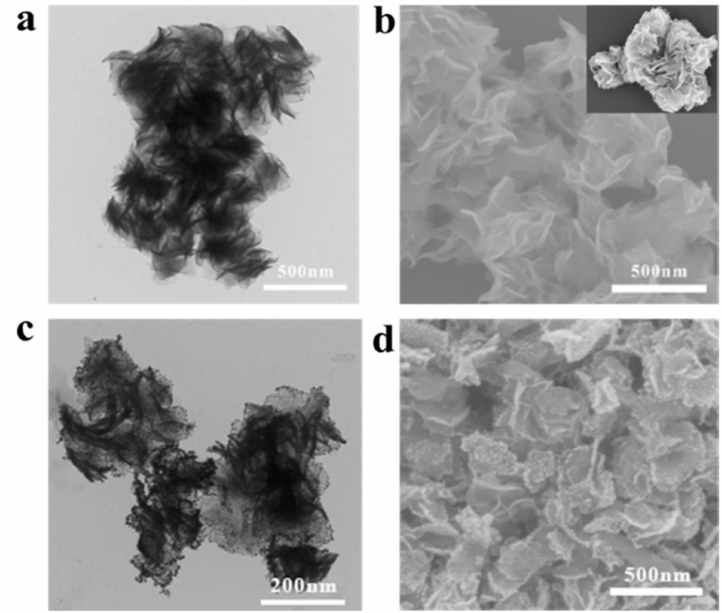
Figure A1. TEM and SEM images of MoS 2 sheets ( a , b ) and MoS 2 /Au heterojunctions ( c , d ). The inset presents a SEM image of MoS 2